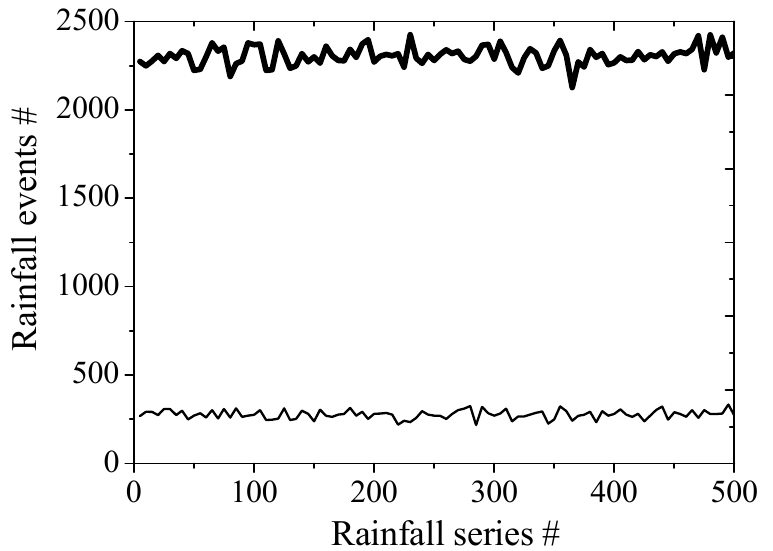
Figure 5. Number of isolated rainfall events in the 500 generated rainfall series. Thick line, rainfall. Thin line, excess rainfall (i.e., rainfall minus infiltration).